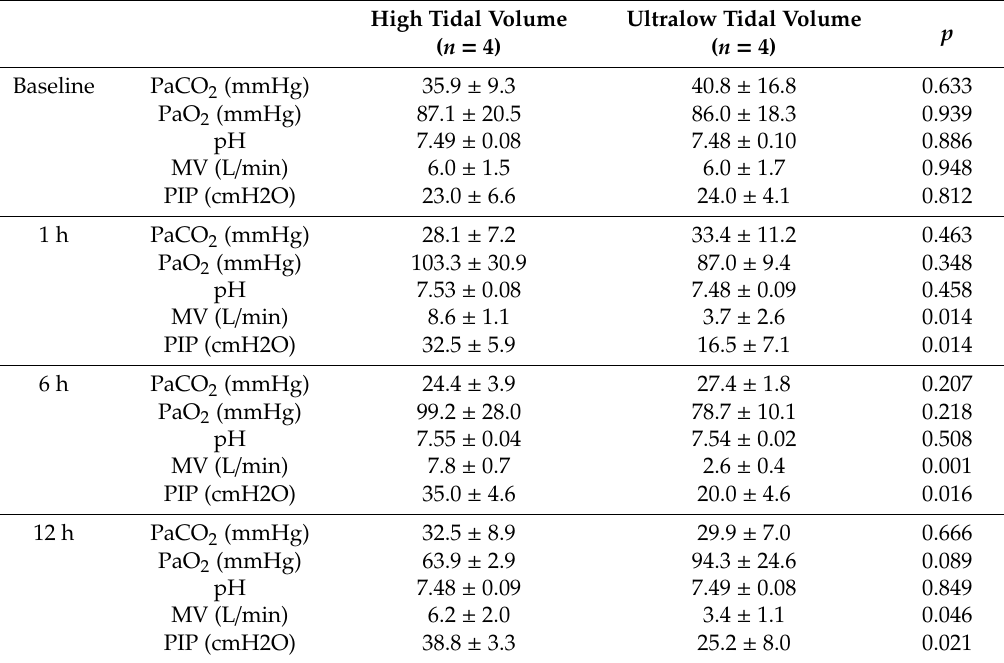
Table 2. Oxygenation and ventilation profiles.